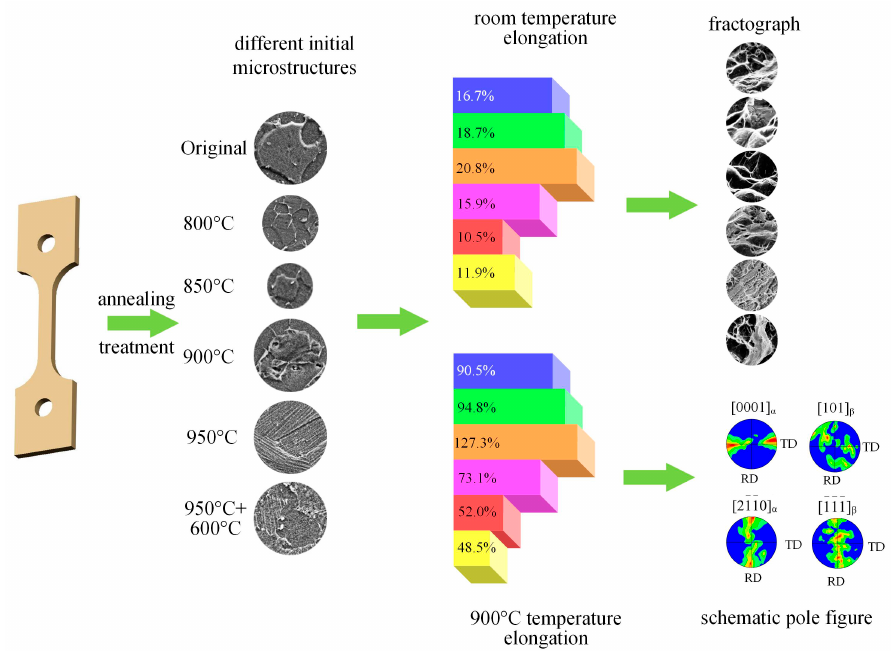
Figure 8. Schematic diagram of mechanical mechanism.